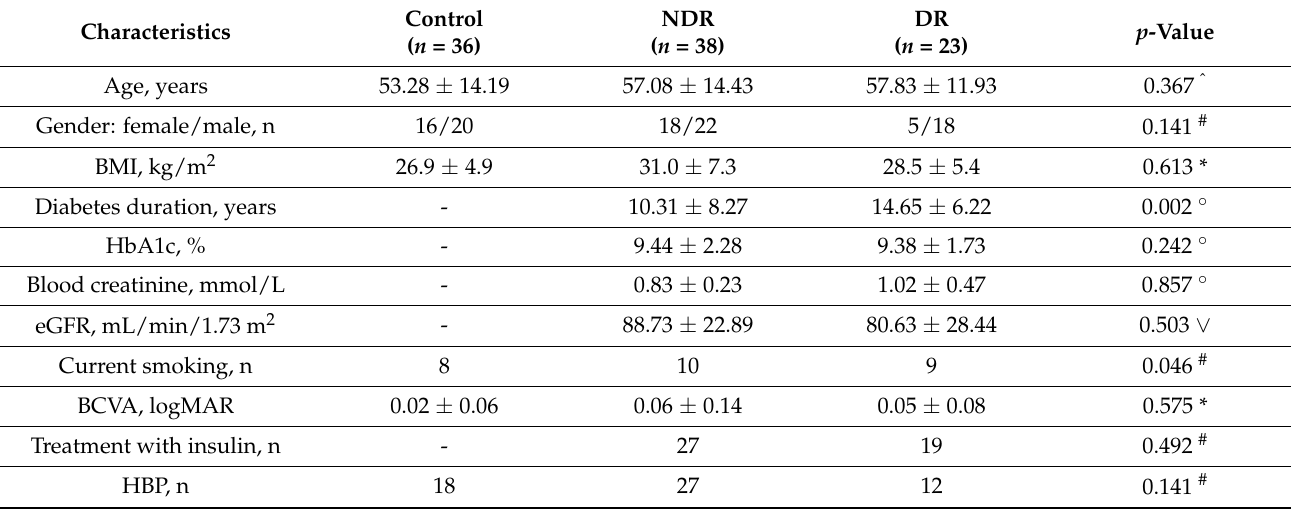
Table 2. Demographic and clinical characteristics of the eyes ( n = 97